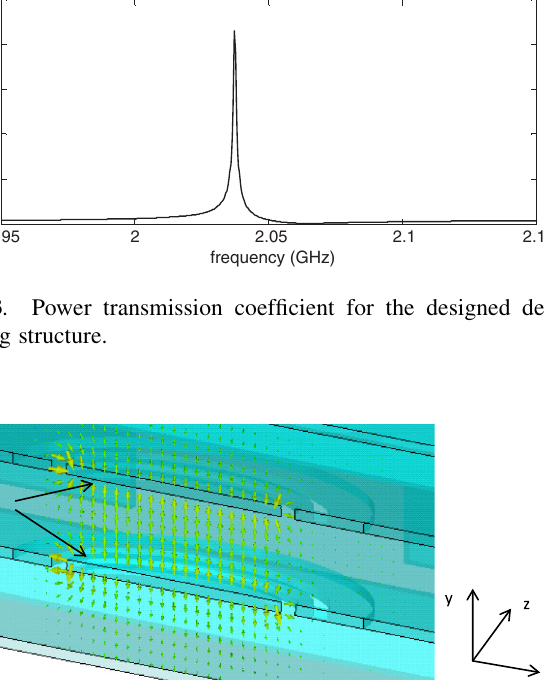
FIG. 4. 2D cut of the electric field at resonance.